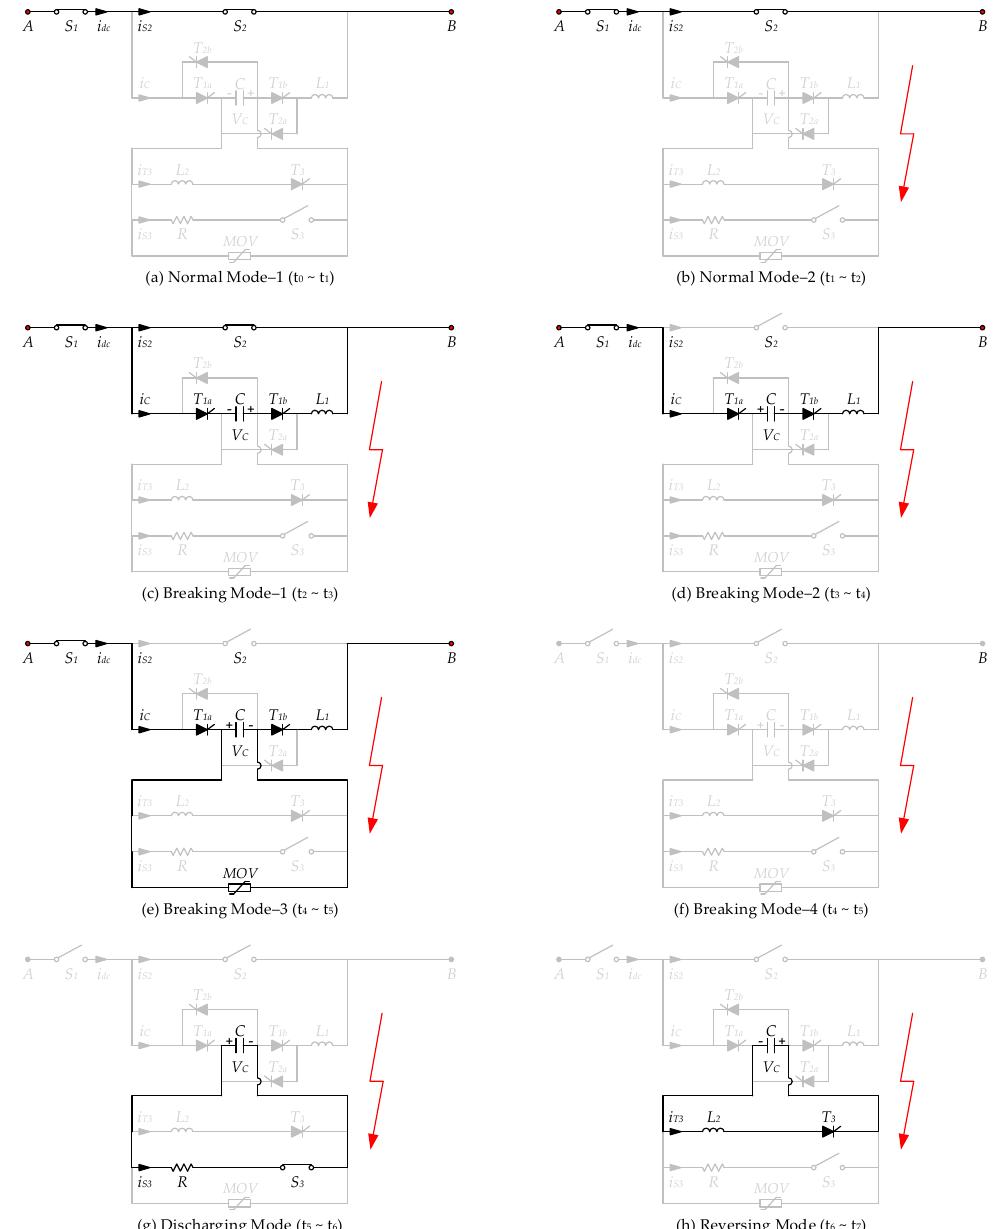
Figure 3. Operating modes of the proposed HCB topology with DC fault at the B-side.